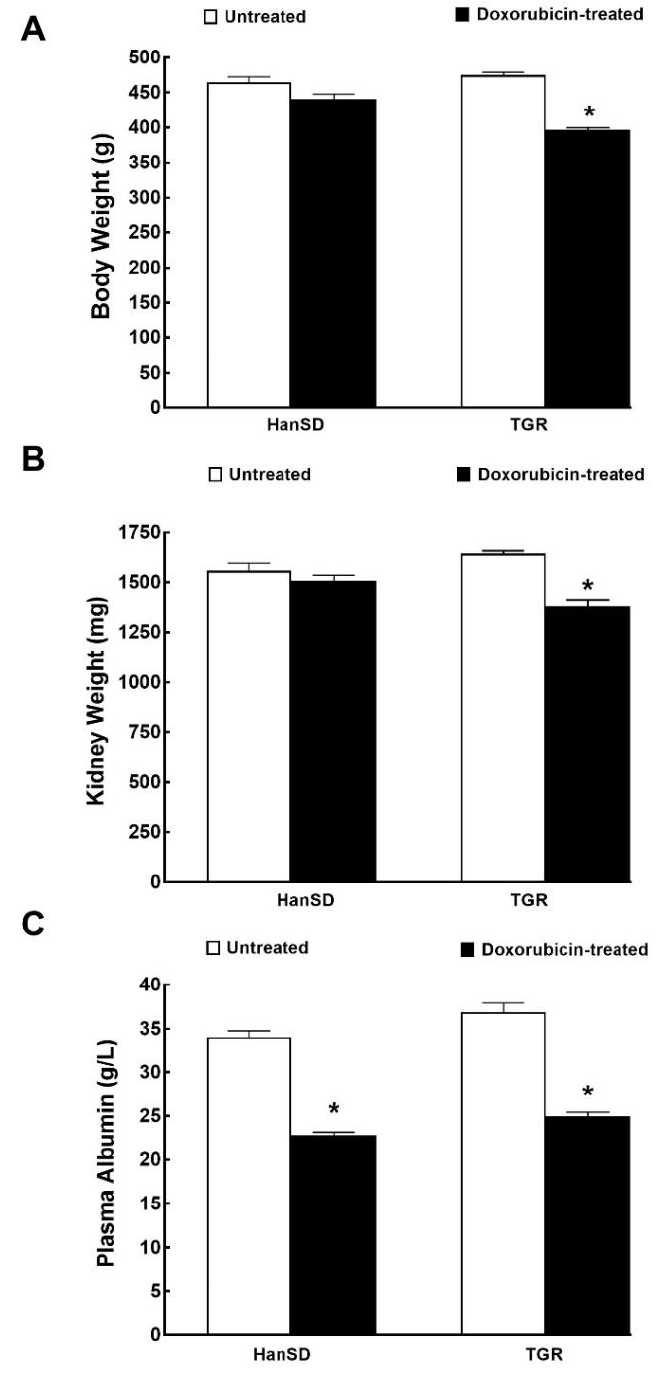
Figure 3. Weights and biochemical parameter. Body weight ( A ), kidney weight ( B ) and plasma albumin levels ( C ) two weeks after the last doxorubicin injection (at the end of the experimental protocol) in normotensive, transgene-negative Hannover Sprague-Dawley (HanSD) and hypertensive, Ren-2 transgenic (TGR) rats. * p < 0.05 compared with untreated animals of the same strain at the same time point. The values are means ± SEM and are pooled from the three series of